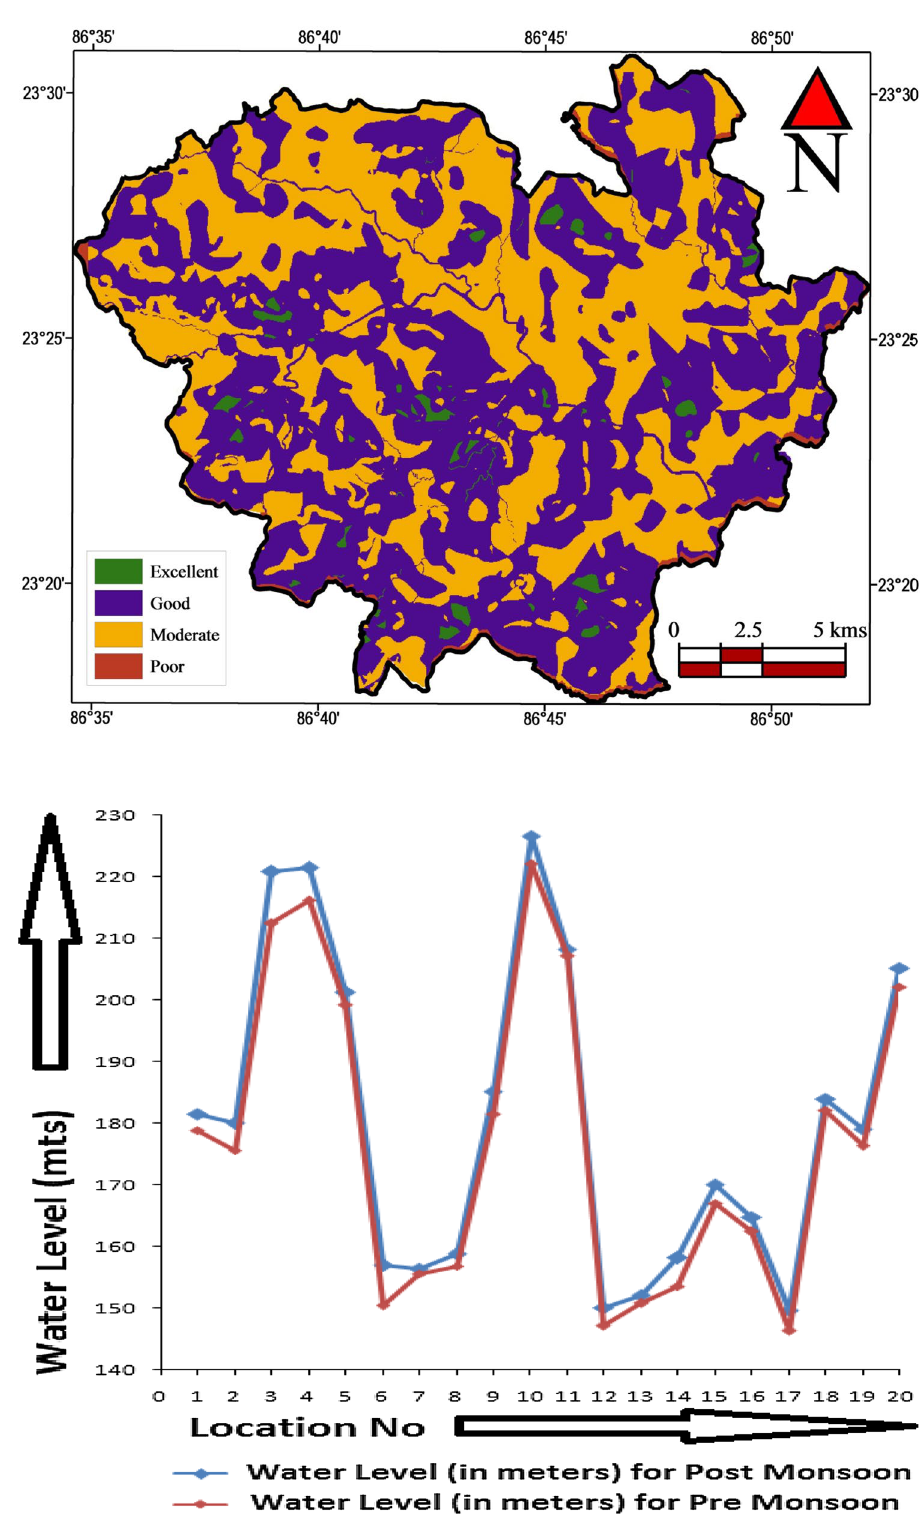
Fig. 9 Map showing groundwa- ter potential zones of the study area